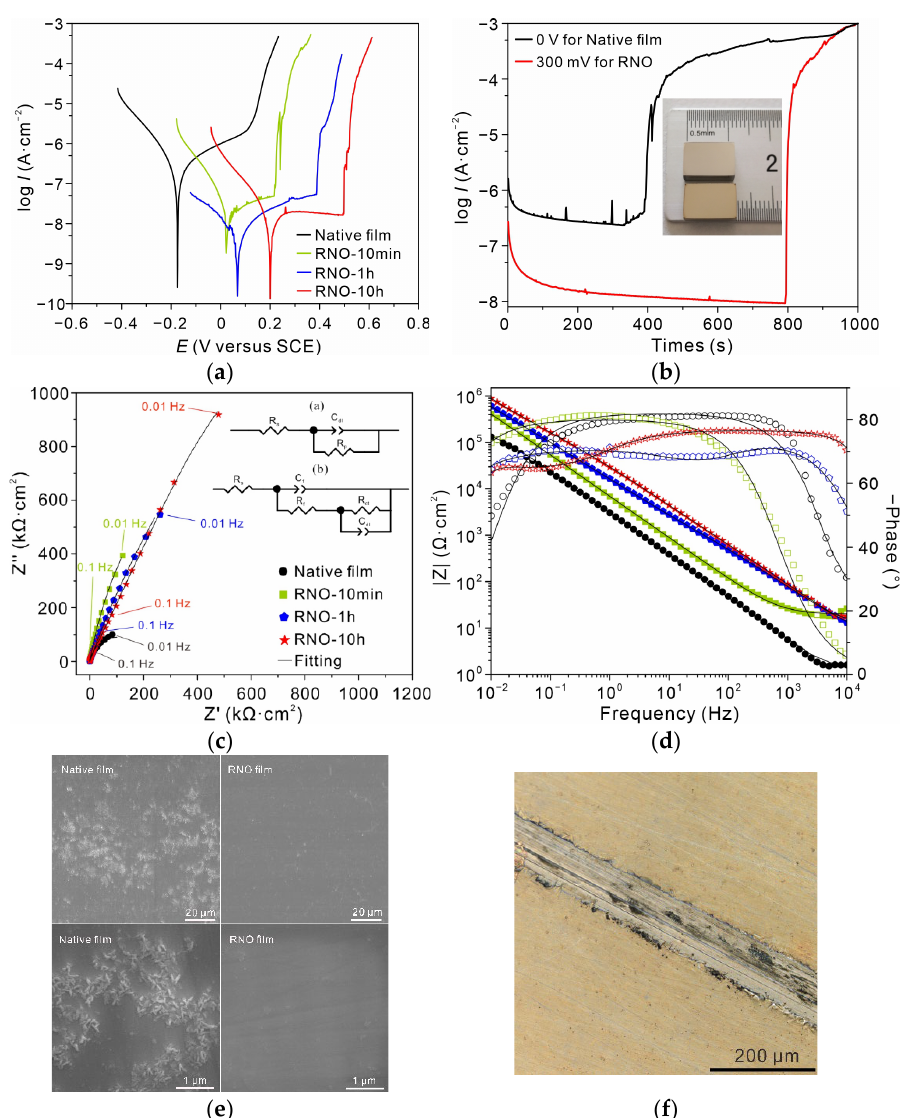
Figure 3. Corrosion electrochemical behavior of the RNO alloy. ( a ) Polarization curves of 316L SS after processing for 0 min, 10 min, 1 h, and 10 h in 0.6 M neutral NaCl solution at room temperature. ( b ) Potentiostatic polarization curves at 0 mV for bare 316L SS and at 300 mV for 1 h of processing, respectively. The inset is the optical photographs of 316L SS (top) and RNO-1h 316L SS (bottom). ( c ) Nyquist plots of the samples and the corresponding EECs used for fitting (solid line); ( a ) for bare 316L SS and RNO-10min; and ( b ) for RNO-1h and RNO-10h, respectively. ( d ) Bode plots and the corresponding fitting lines. ( e ) SEM surface morphology of bare (left) and RNO (right) alloys after six months of salt spray testing (40 ◦ C). ( f ) Optical microscopy photograph of the scratched RNO alloy after 3 weeks of immersion in 1M neutral NaCl solution at 80 ◦